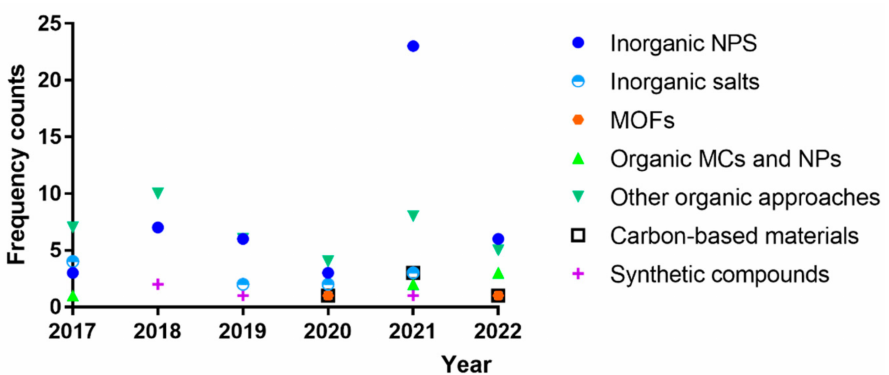
Figure 3. Approximate frequency counts of the usage of different categories of antimicrobial agents within protective textiles (intended for the military, first responders, or civilians) within published literature of the last 5 years (database: